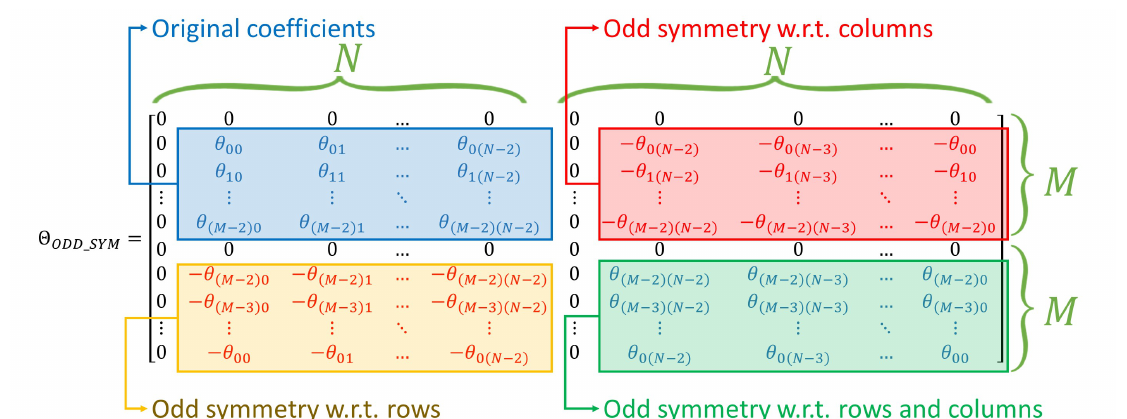
Figure 5. Matrix structure for the odd symmetry FFT (1D and 2D). The blue block contains the original coefficients and the remaining blocks contain their odd-symmetry counterpart. All blocks are separated by rows and columns of